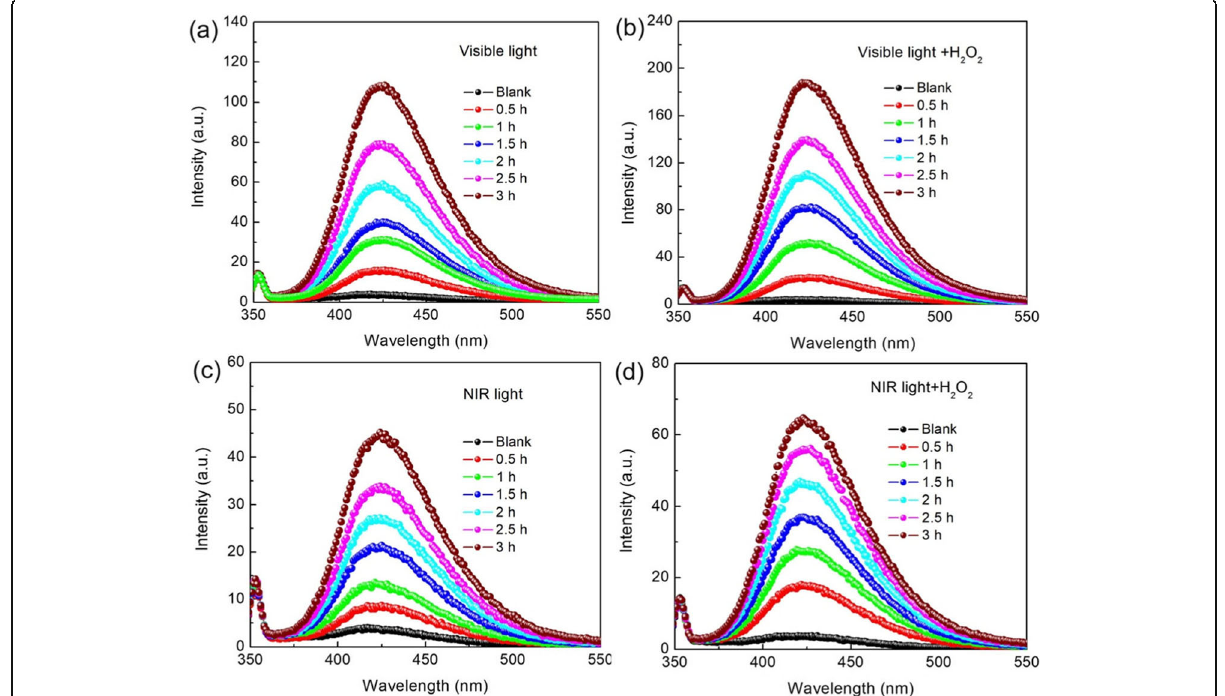
Fig. 11 a and b PL spectra of the TA solution as a function of visible light irradiation time over the 12C/BFO sample in the photocatalytic and photo-Fenton catalytic reactions, respectively. c and d PL spectra of the TA solution as a function of NIR light irradiation time over the 12C/BFO sample in the photocatalytic and photo-Fenton catalytic reactions, respectively